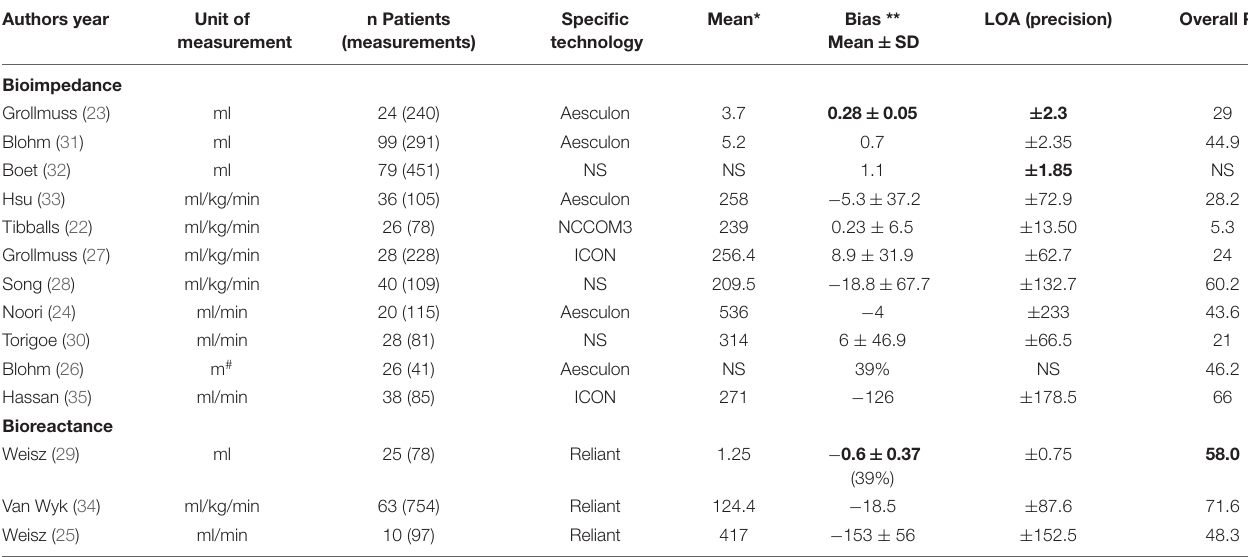
TABLE 8 | Outcome measure for studies using bioimpedance or bioreactance technology. Authors